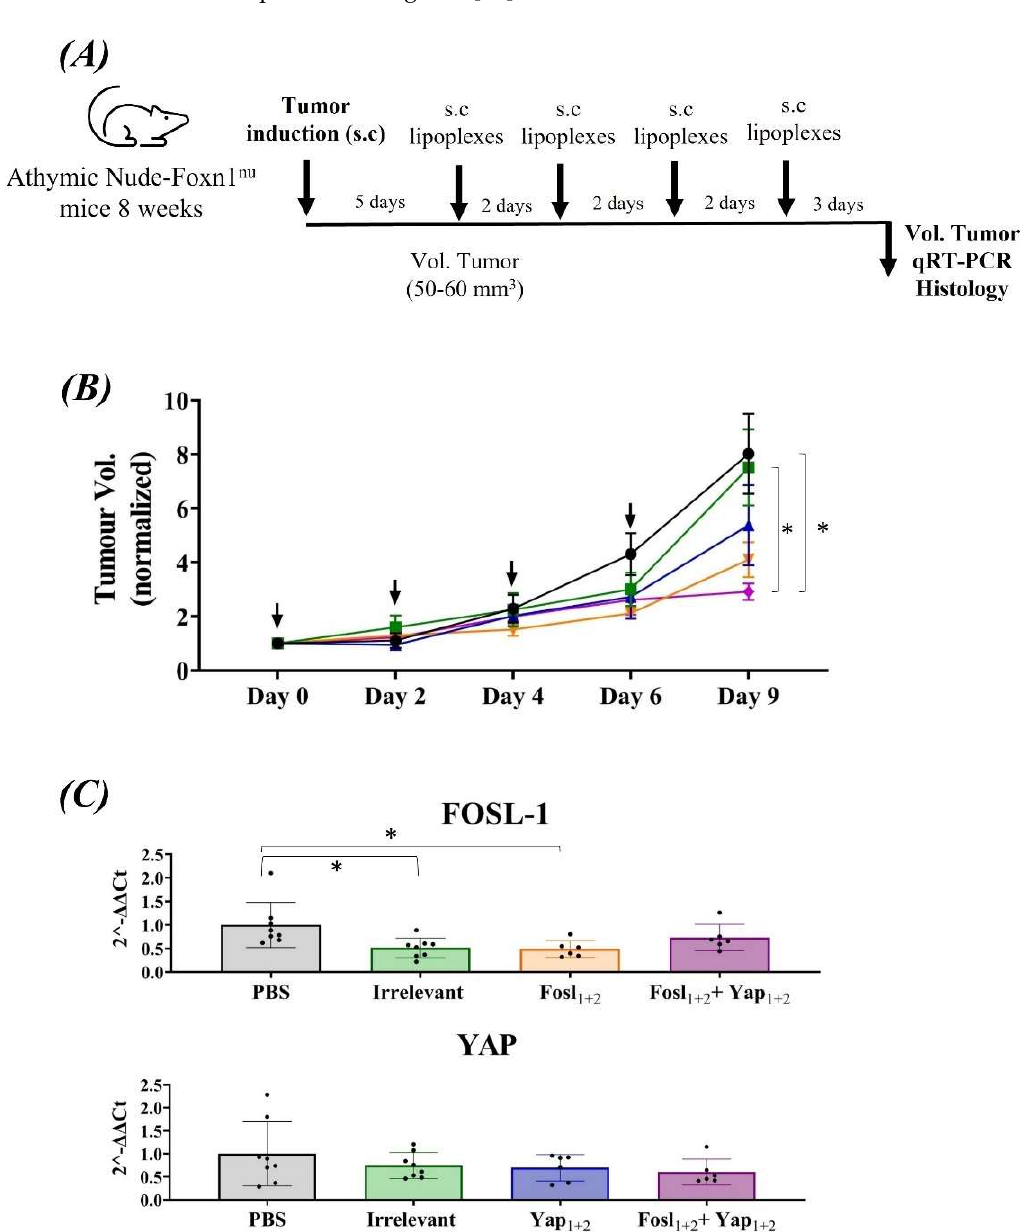
Figure 6. Anti-tumoral efficacy of lipoplexes in ATQ303G cell − allografted Athymic Nude − Foxn1 nu mice ( n = 8). ( A ) Schedule of the study, including subcutaneous tumor cells inoculation and subse- quent subcutaneous injection of the lipoplexes around the tumor. ( B ) Tumor size was normalized at the first day of drug administration (5 days after tumor cells inoculation). ( C ) mRNA expression of FOSL-1 and YAP after 72h of the last lipoplexes administration. The differences between PBS and the treatments were represented as: * p ≤ 0.05; while between irrelevant lipoplexes and treatments were represented in brackets (*) p ≤ 0.05. PBS (black), Irrelevant (green), Fosl 1+2 (brown), Yap 1+2 (blue) and combination of Fosl 1+2 + Yap 1+2 (purple).